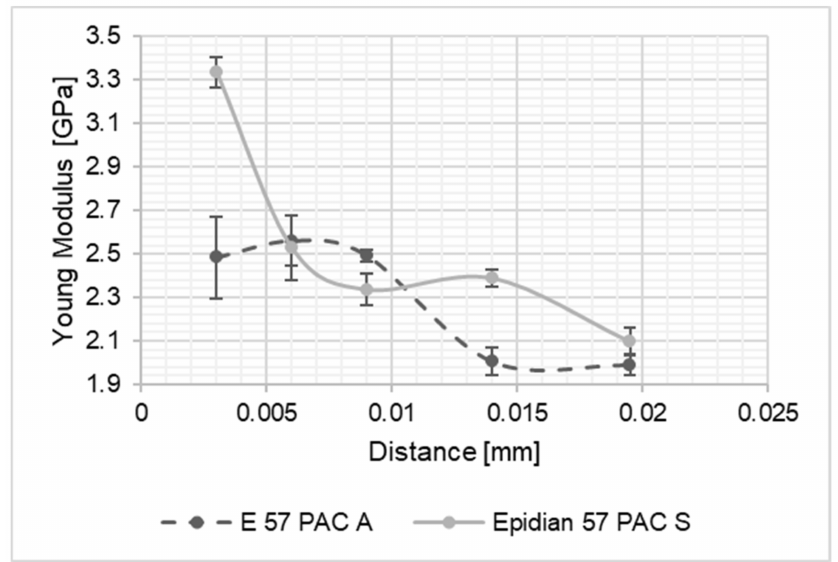
Figure 6. Comparison of Young’s modulus values for the Epidian 57/PAC joint bonding: A— aluminium alloy sheets; S—stainless steel sheets, as above.